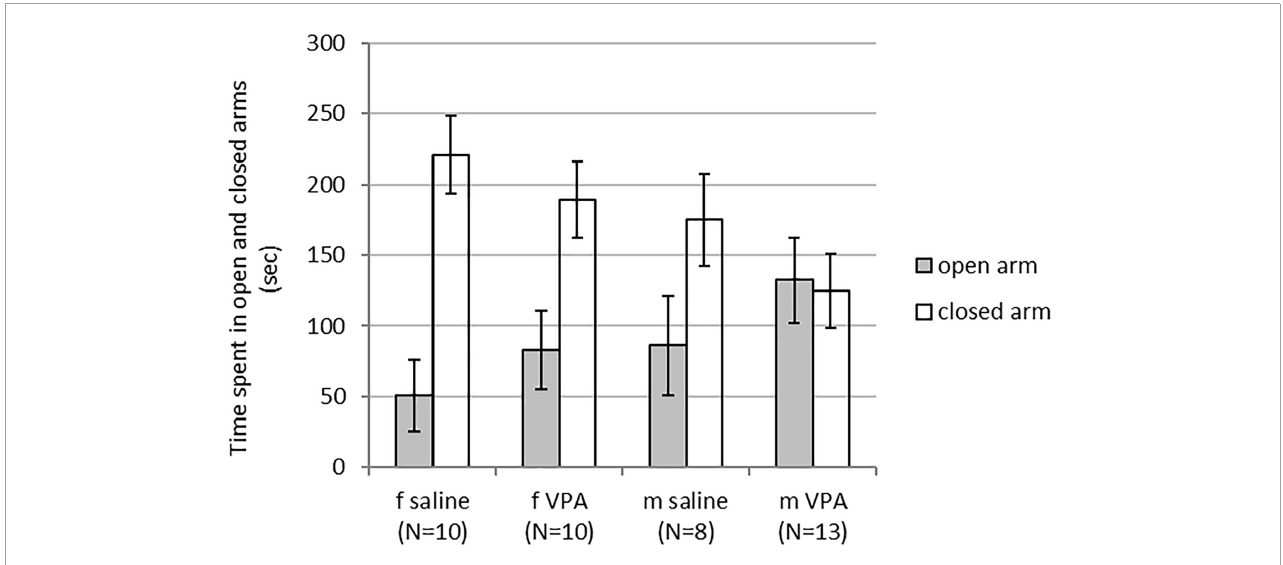
FIGURE1 Behavior of control and valproate (VPA) mice in the elevated plus maze (EPM). No differences were observed between the